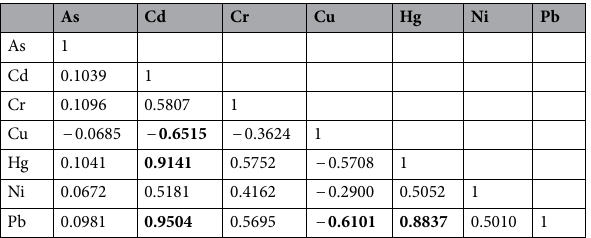
Exposure dose (μg/kg bw/day) Mean P97.5 Mean P97.5 Mean P97.5